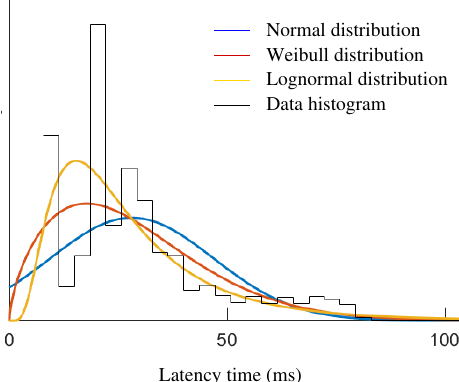
Figure 8. Histogram of measured latency times together with several adjusted probability distributions; in the Y axis, number of occurrences.